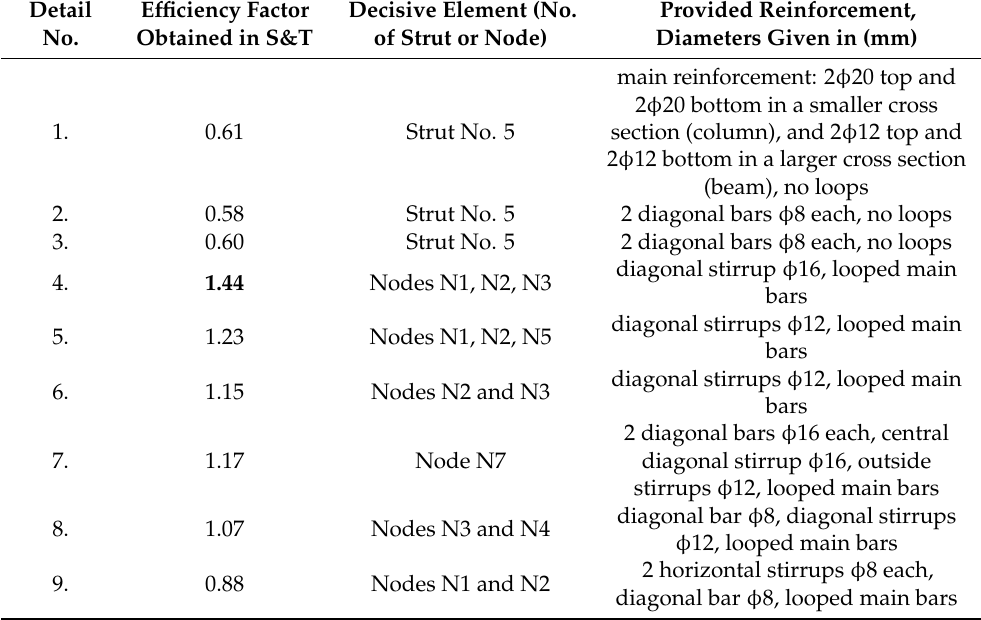
Table 5. Efficiency factors and provided reinforcement for each reinforcement detail—the case of elements with different cross section heights (maximal value in bold).